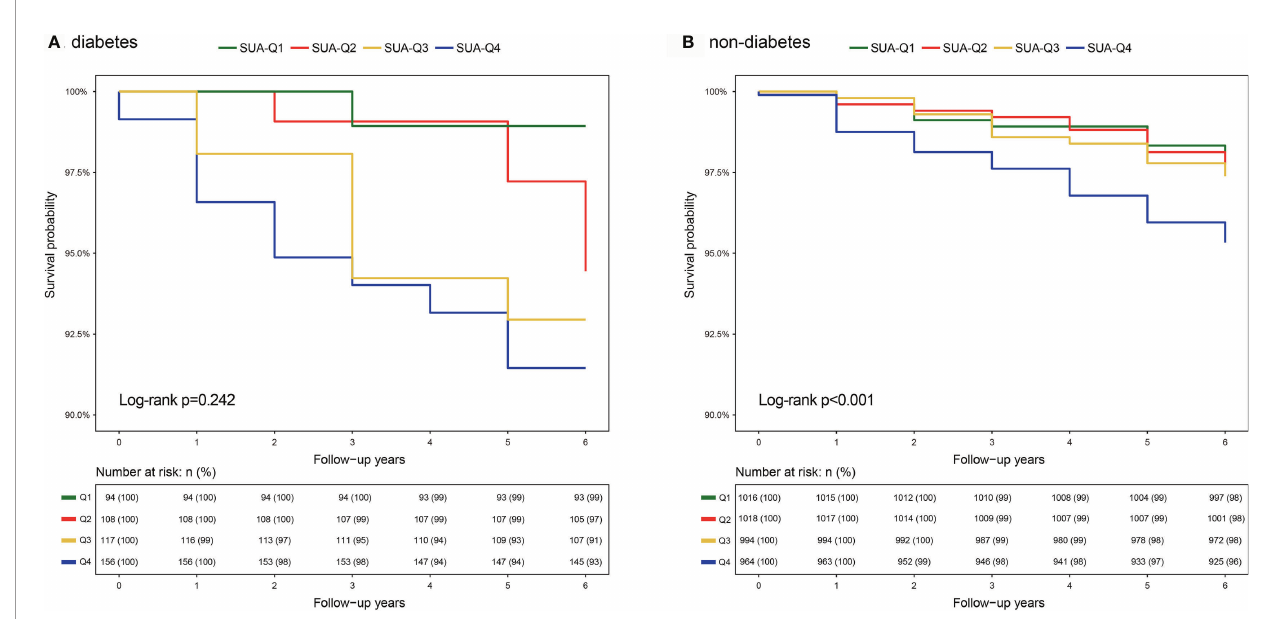
FIGURE 1 | K-M curves of SUA quartiles for all-cause mortality among individuals with and without diabetes (A) Diabetic individuals, (B) Non-diabetic individuals. Abbreviations are indicated in Table 1 ).